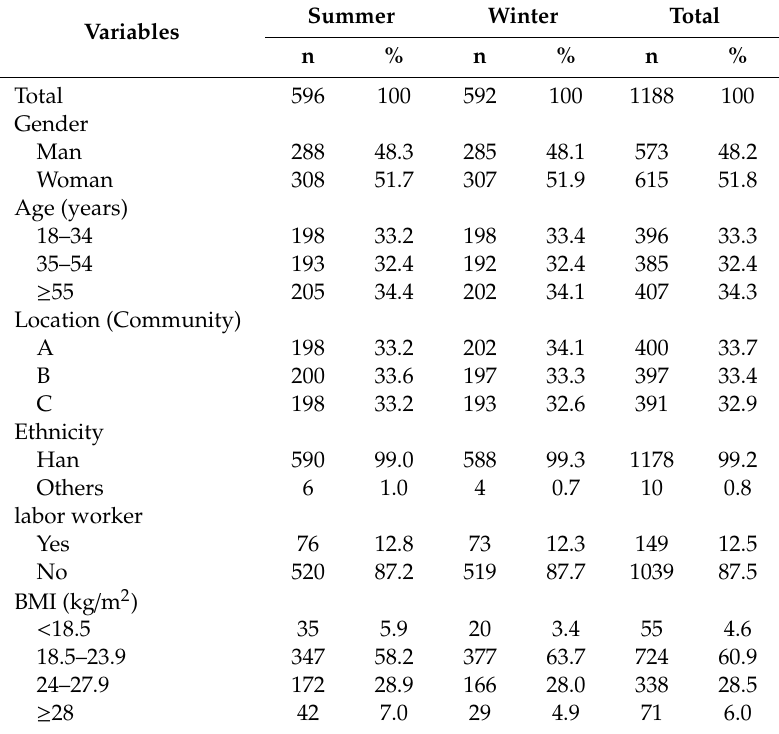
Table 1. Demographic characteristics of the participants in summer and winter.